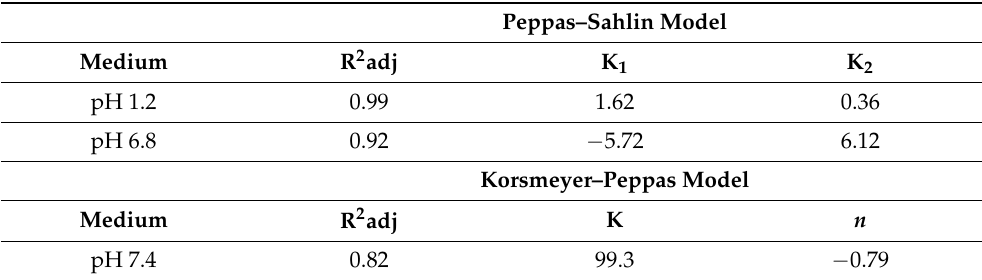
Table 2. Representation of experimental data from the kinetic models that best fit the different release